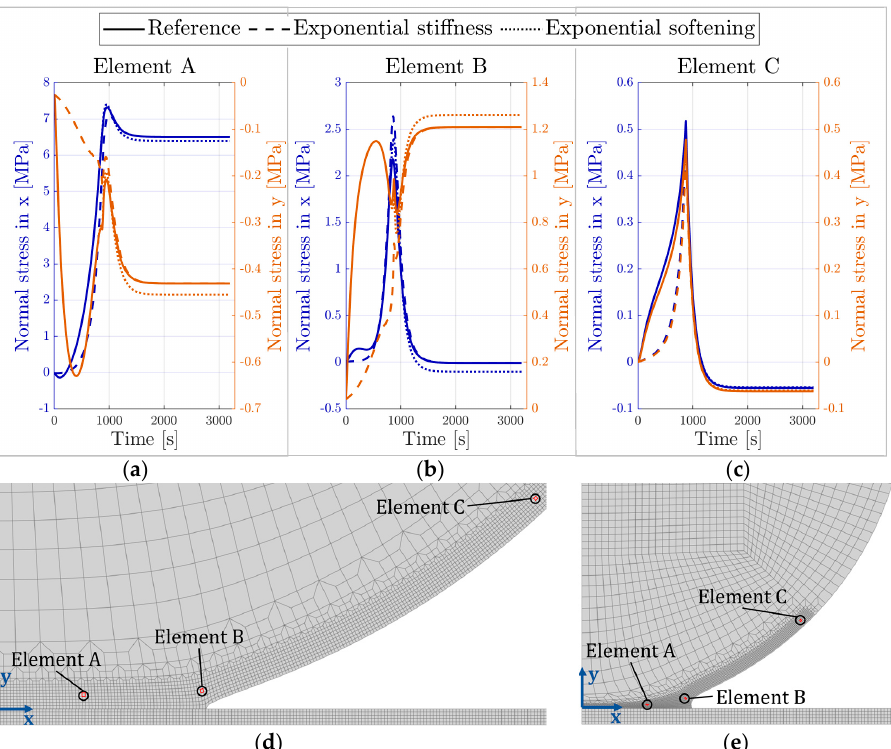
Figure 10. Element investigation: ( a – c ) stresses in two directions in three elements of the model for the parameter variations, and position of the elements in the model ( d ) before the onset of shrinkage and ( e ) after finalised shrinkage.